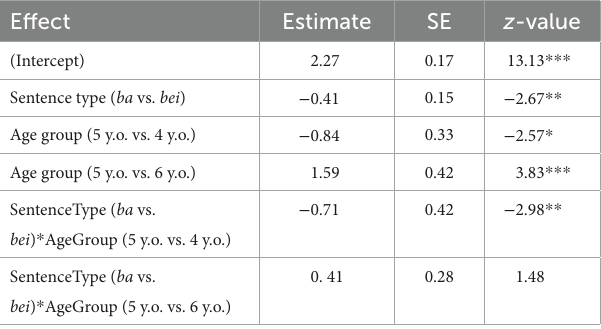
TABLE 7 Fixed effect estimates for multi-level model of sentence production.